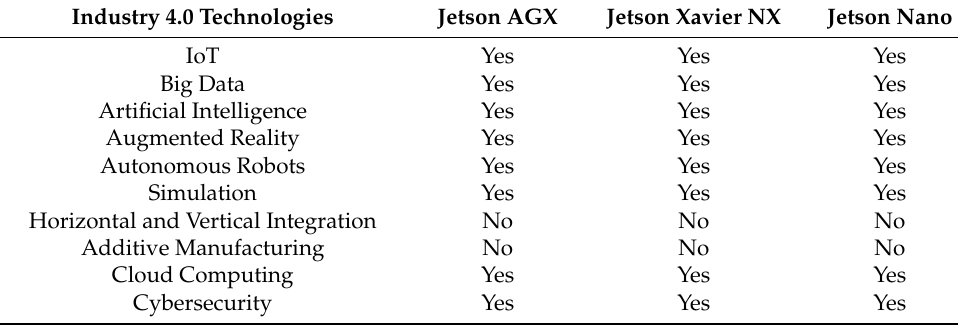
Table 2. Evaluation of selected devices in terms of Industry 4.0 attributes.